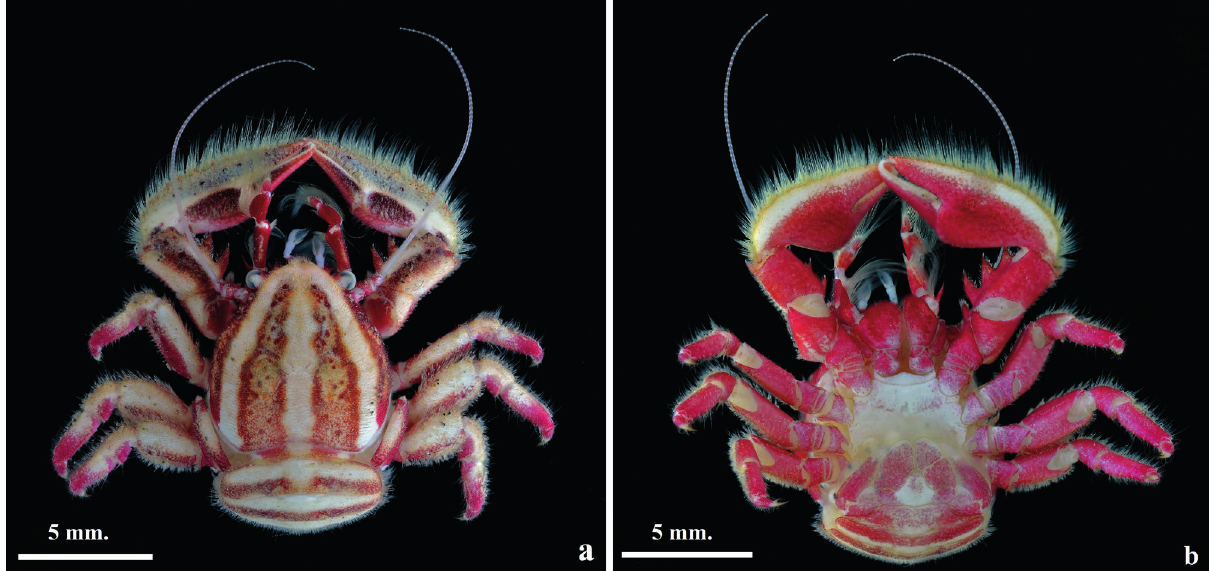
Figure 1. Petrolisthes virgatus Paul’son, 1875, adult female, carapace length = 6.19 mm, carapace breadth = 5.47 mm, Djod village, Gulf of Oman, 10 October 2014. (a) Dorsal view; (b) ventral view. Photo credit: R.